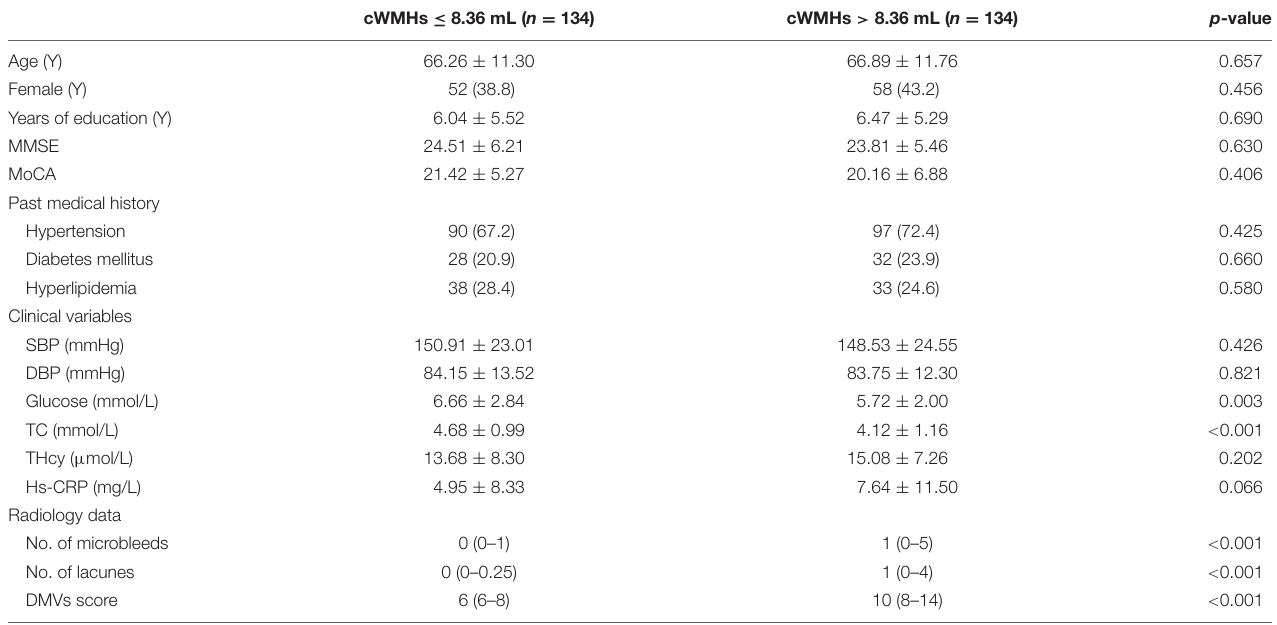
TABLE 1 | Basic data in different corrected WMHs (cWMHs) volume groups.